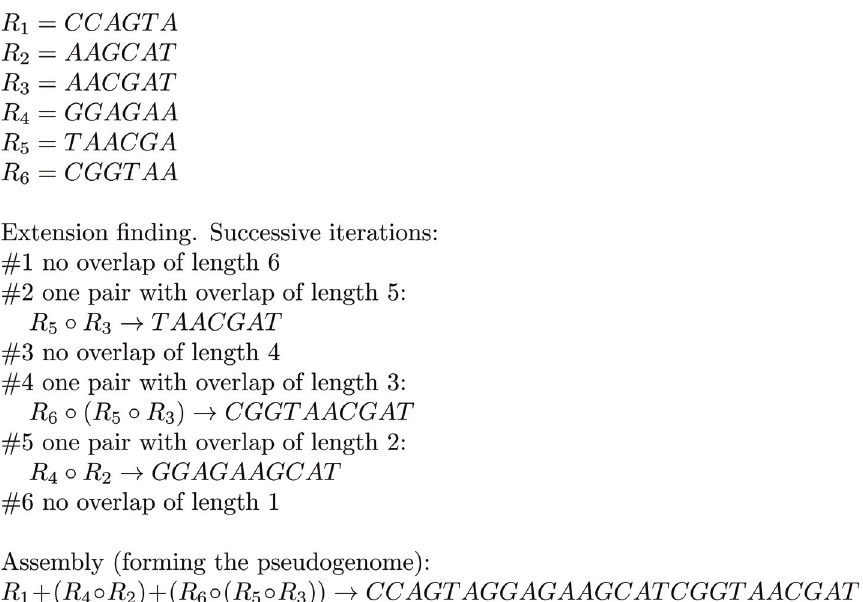
Fig 1. Pseudogenome generation example. The input read collection R contains 6 reads of length